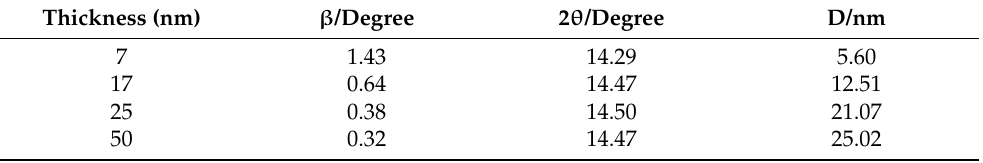
Table 1. The calculated grain size of MoS 2 TFs on sapphire from the (002) peak using Scherrer’s formula. Thickness (nm) β /Degree 2 θ